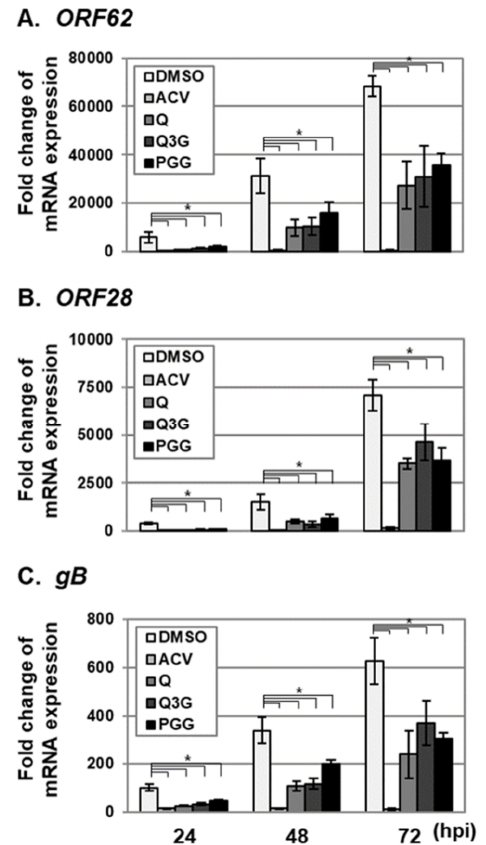
Figure 4. Effects of quercetin and isoquercitrin on VZV lytic-gene expression. HFF cells were inoculated with VZV–pOka-infected HFF cells at an MOI of 0.1, followed by treatment with DMSO, quercetin (Q), and isoquercitrin (Q3G) or 1,2,3,4,6-penta-O-galloyl-ß-D-glucose (PGG) at a concentration of 20 µg/mL. As a control, VZV–pOka-infected HFF cells were treated with ACV (1.2 µg/mL). At 24, 48, and 72 h after infection, total RNA was isolated and reverse-transcribed into cDNA. Relative expression of ( A ) ORF62 (IE), ( B ) ORF28 (E) and ( C ) gB (L) mRNA was assessed via qRT–PCR. For quantification of the relative abundance of viral mRNA between samples, the value of virus-infected cells treated with DMSO was set at 100. Significant differences between samples were determined using Student’s t test (significant at * p < 0.05). Data shown here represent three independent sets of experiments.